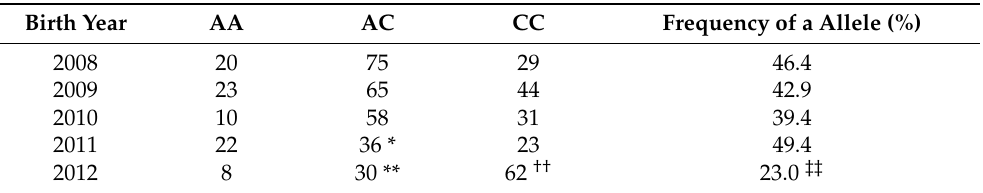
Table 2. Allele frequency of NOD2 -2197 in the Duroc population.